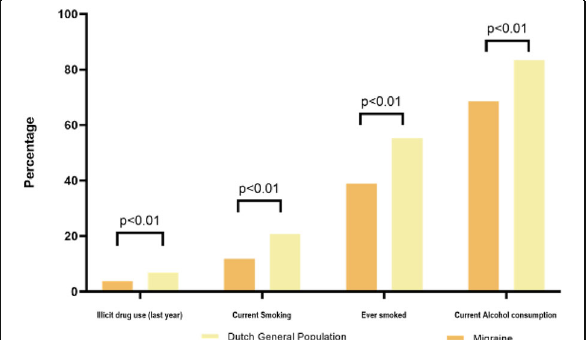
Fig. 1 (abstract A38). Substance use for Dutch General population and migraine patients after standardization adjusting for age, sex and